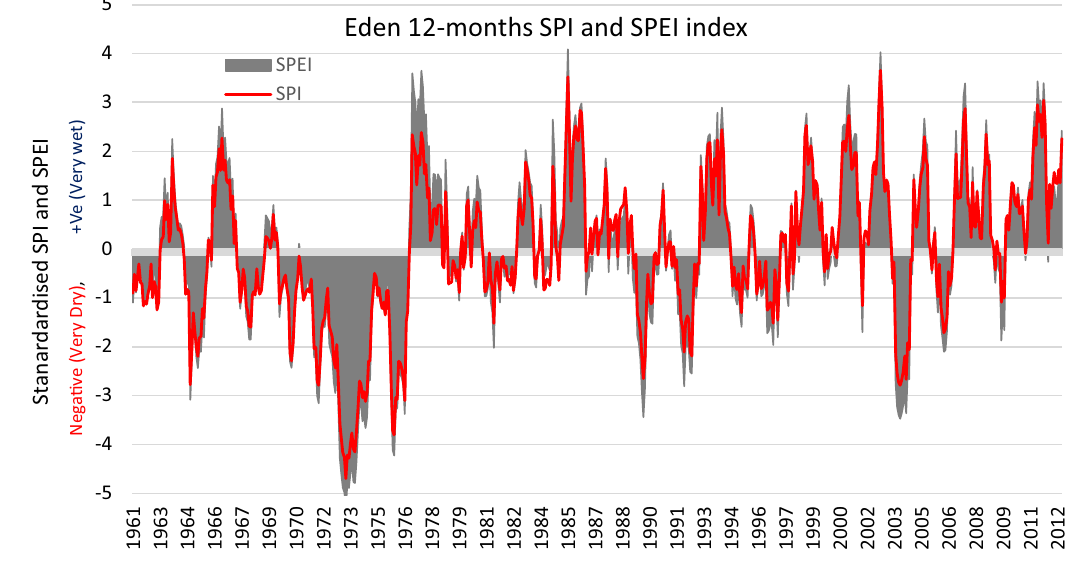
Fig. 9 The standardized precipitation Index ( SPI ) and standardized precipitation – evapotranspiration ( SPEI ) index from 1961 to 2012 Fig. 10 Reconnaissance drought index (RDI) and Adjusted RDI for the 1962 to 2012 time